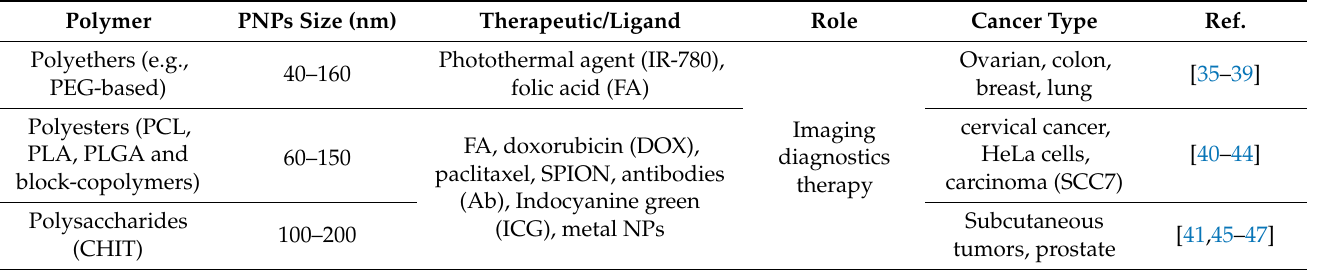
Table 1. Examples of polymer types designed to form PNPs for cancer diagnostics, imaging